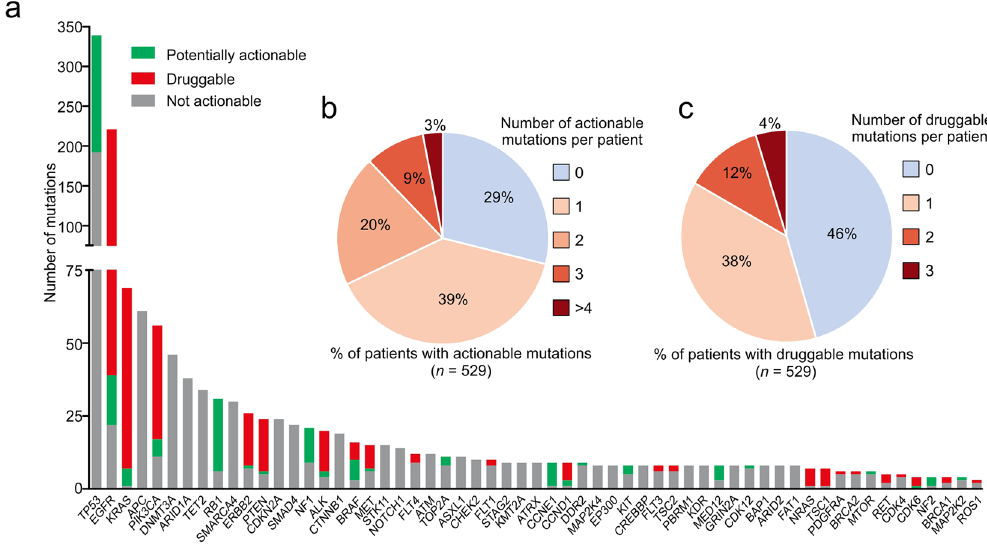
Figure 5. Clinically-actionable mutations identified in ctDNA samples. ( a ) Genes that are frequently mutated in cancer were ranked by their mutation frequency in all ctDNA samples tested, with the proportion of currently druggable mutations and potentially actionable mutations highlighted in red and green, respectively. Genes with low mutation occurrences ( ≤ 4) were not shown. ( b ) The percent of patients that presented with varying numbers of clinically-actionable mutations. ( c ) The percent of patients that presented with varying numbers of druggable